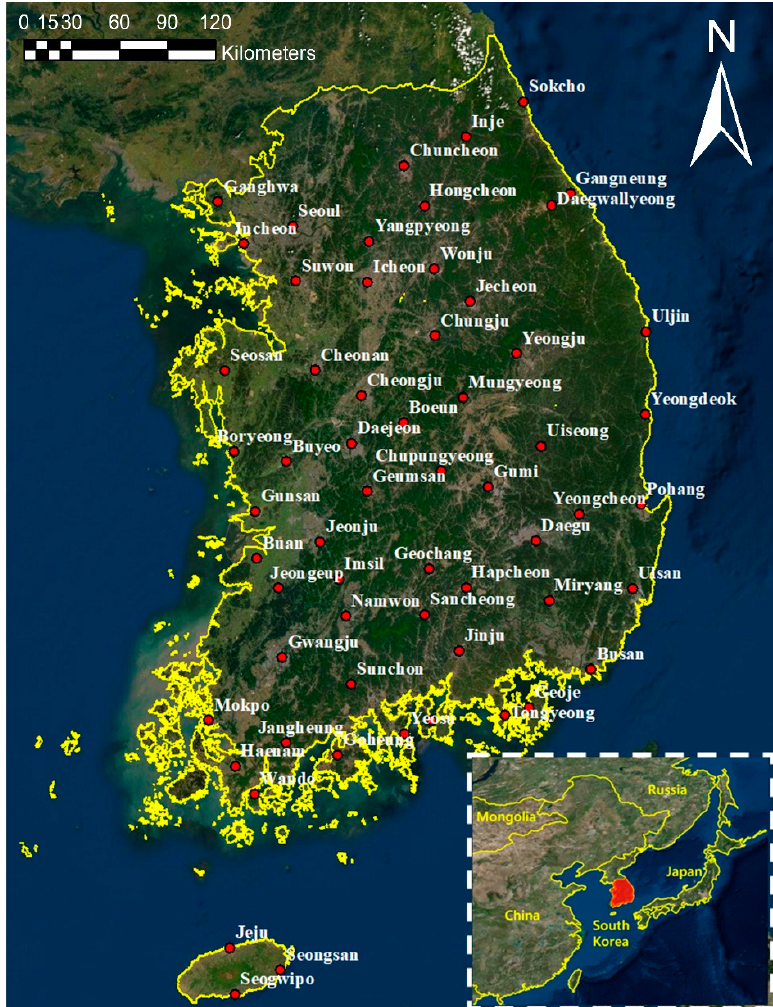
Figure 1. Location of selected weather station in South Korea.